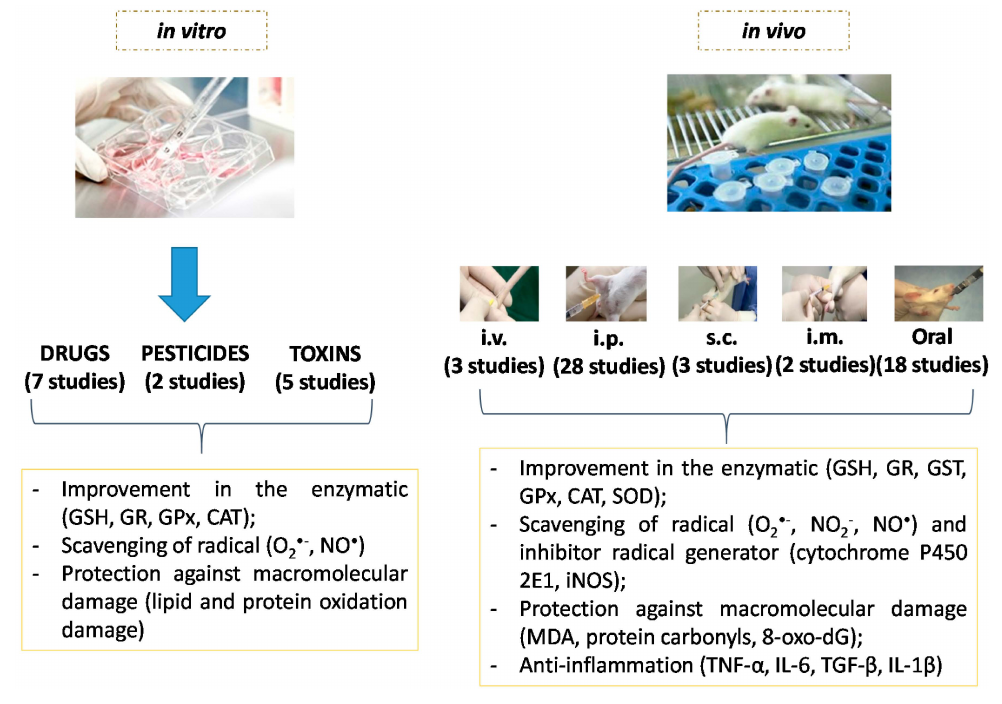
Figure 5. Positive effects of N -acetylcysteine in vivo and in vitro tests evaluated in this review and its mains